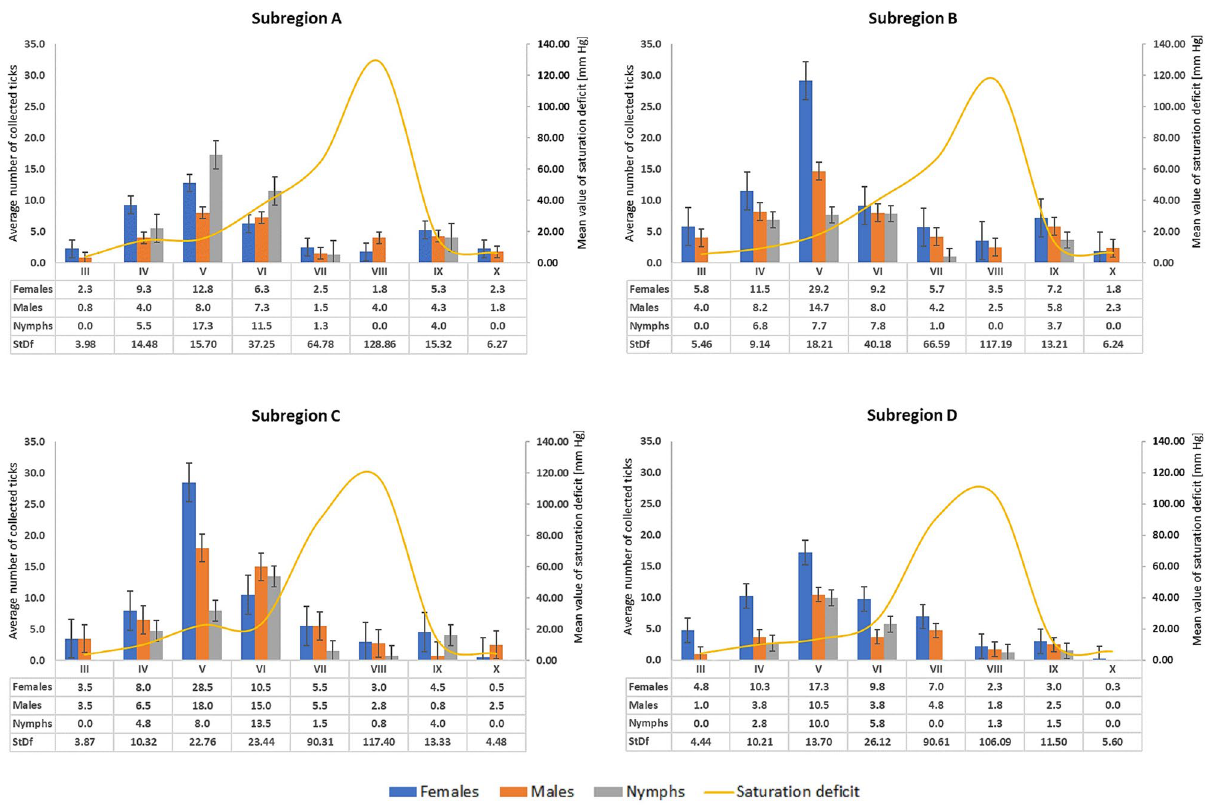
Figure 1. Mean number (with standard error) of Ixodes ricinus ticks collected in localities in south-eastern Poland subregions with different microclimatic characteristics